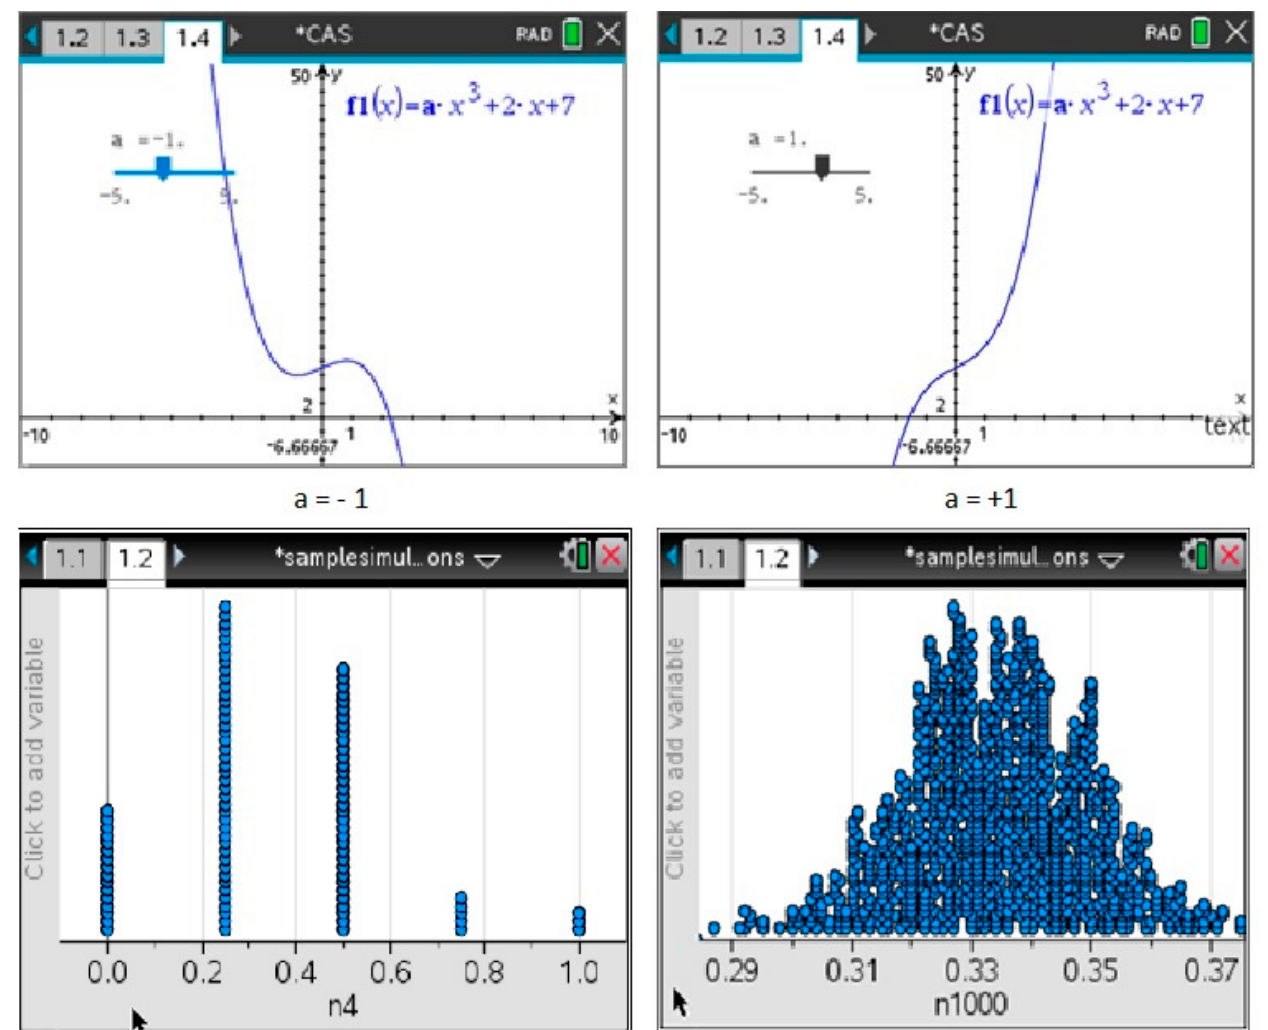
Figure 8. Two examples of visualization to support conceptual development .